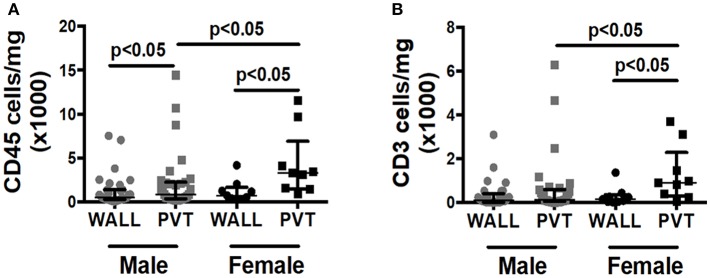
Effect of patient gender on immune cell numbers in AAA wall and PVT. Male vs. female total leukocyte and T cell content in AAA PVT and wall. (A) Leukocyte number per mg of aneurysmal wall and PVT in male group n = 31 vs. female group n = 9 (B). T cell number per mg of aneurysmal wall and PVT in male group n = 30 vs. female group n = 9. Mann-Whitney test for comparison male vs. female for wall and PVT, Wilcoxon test for comparison wall vs. PVT within male and female group. p values presented on graphs only for statistically significant comparisons.